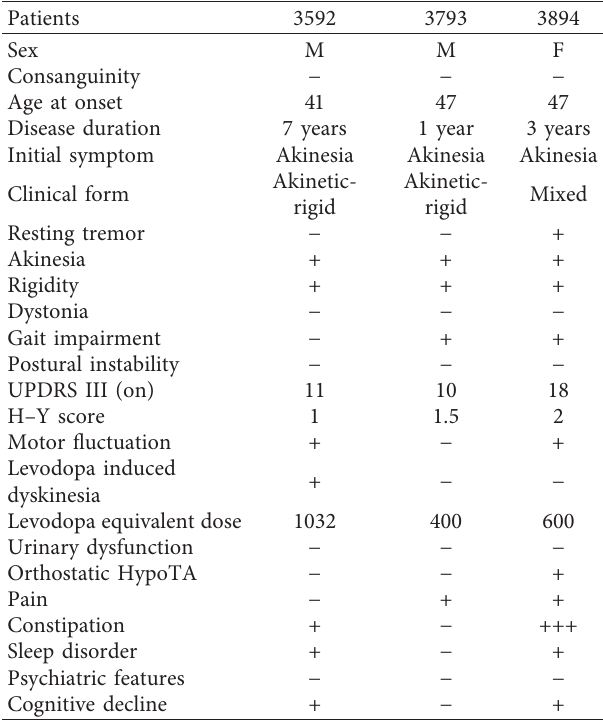
Table 3: Clinical features of the 3 Moroccan PD patients with the MAPT H2/H1j